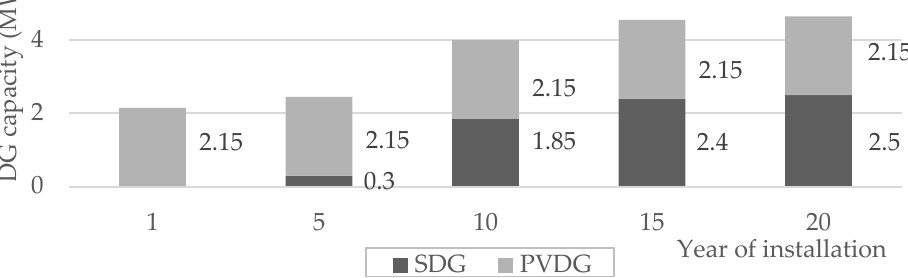
Figure 4. Installation capacity of distributed generation (DG) units.